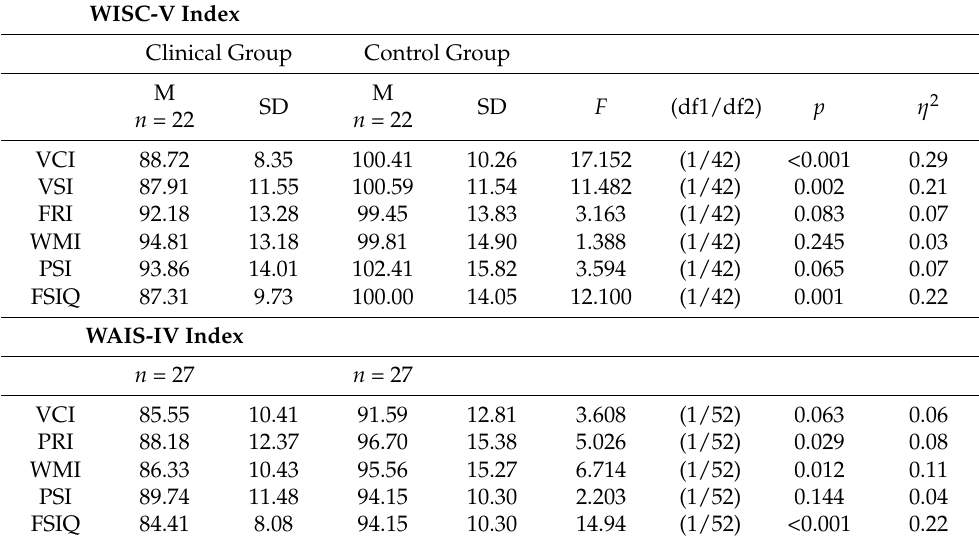
Table A1. MANOVA results, means and standard deviations for the primary indices for the WISC-V and WAIS-IV by group.